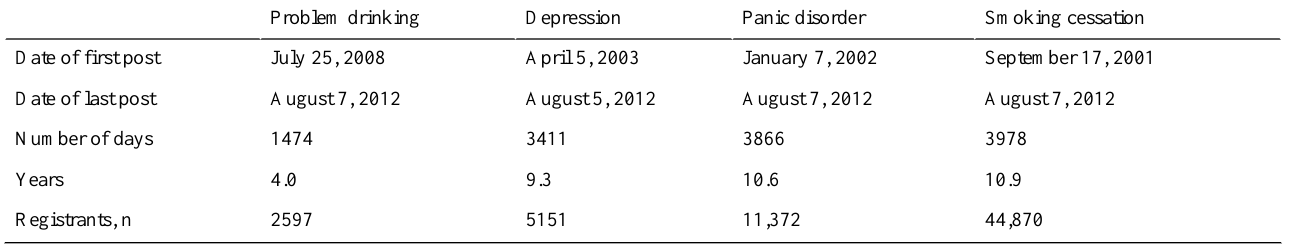
Table 2. Subjects and study duration.